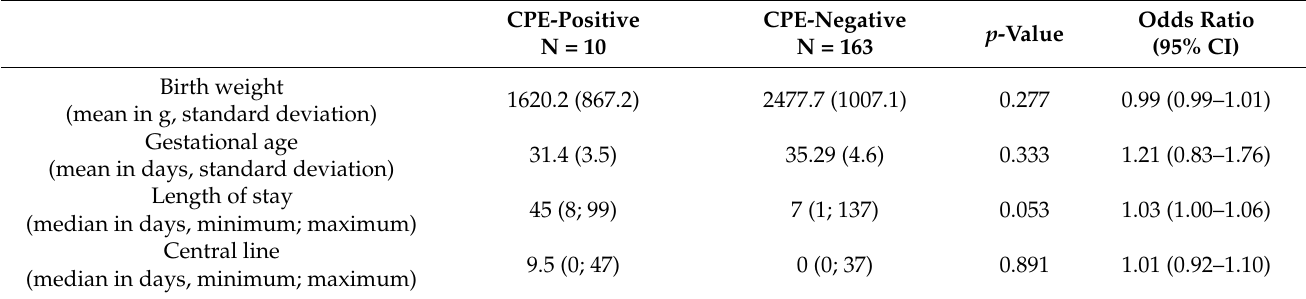
Table 2. Multivariable analysis of risk factors for carbapenemase producing Enterobacterales (CPE) gut colonization. CPE-Positive N =